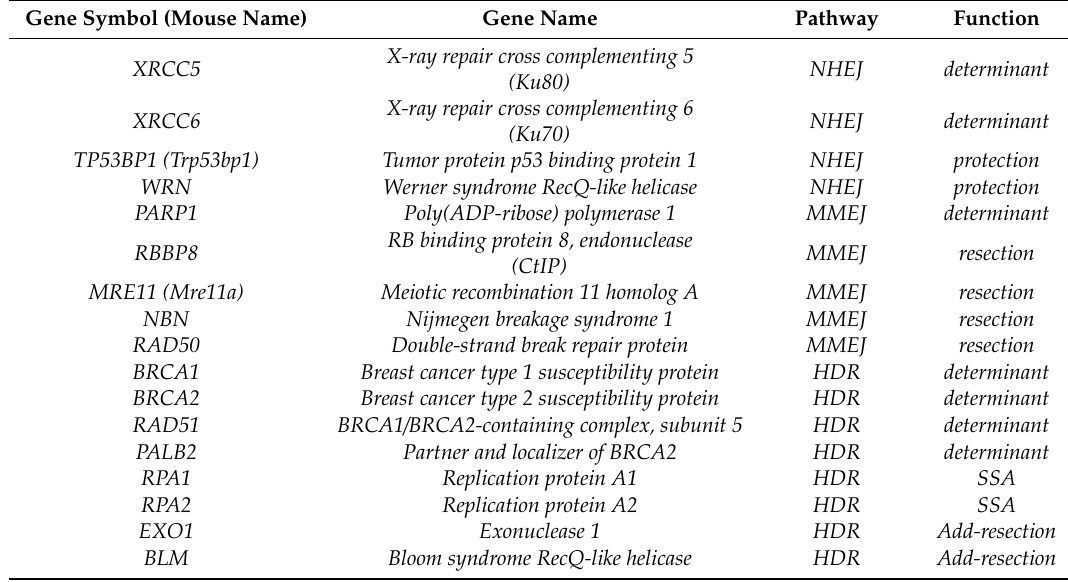
Table 1. Curated double-strand break repair pathways genes. This table lists key components of DSB repair pathways as discussed in Methods 4.1.